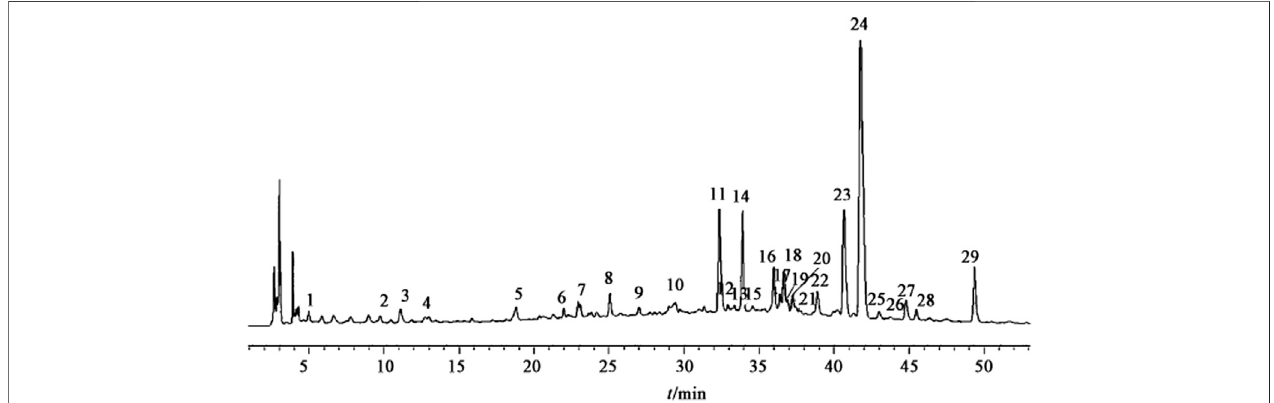
FIGURE 4 | HPLC fi ngerprint and identi fi cation of peaks of XSN capsules. (Zhang et al., 2017).